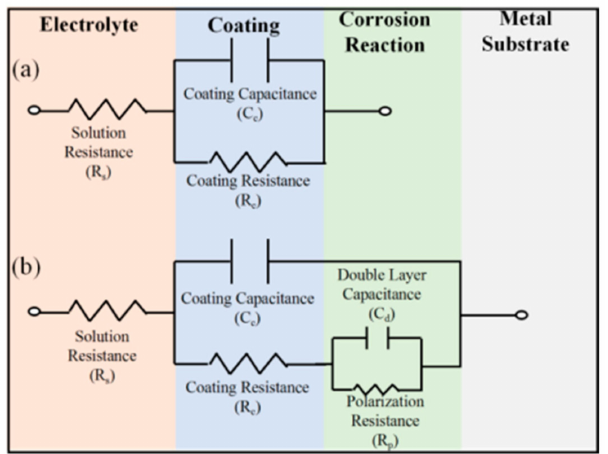
Figure 9. Equivalent electrical circuit of coatings ( a , b ).